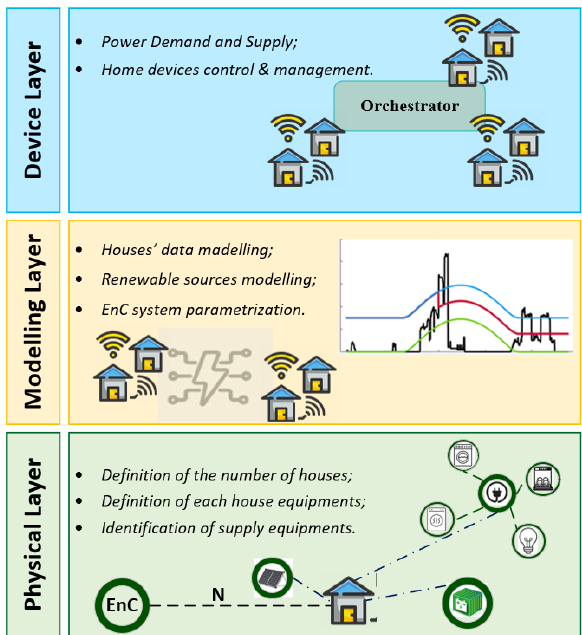
Figure 5. EnC modelling layers.